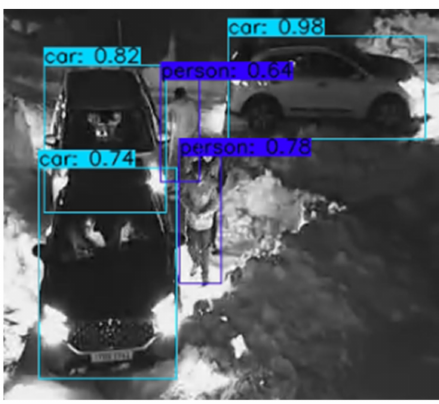
Figure 8. Some of the images captured during the inference performance